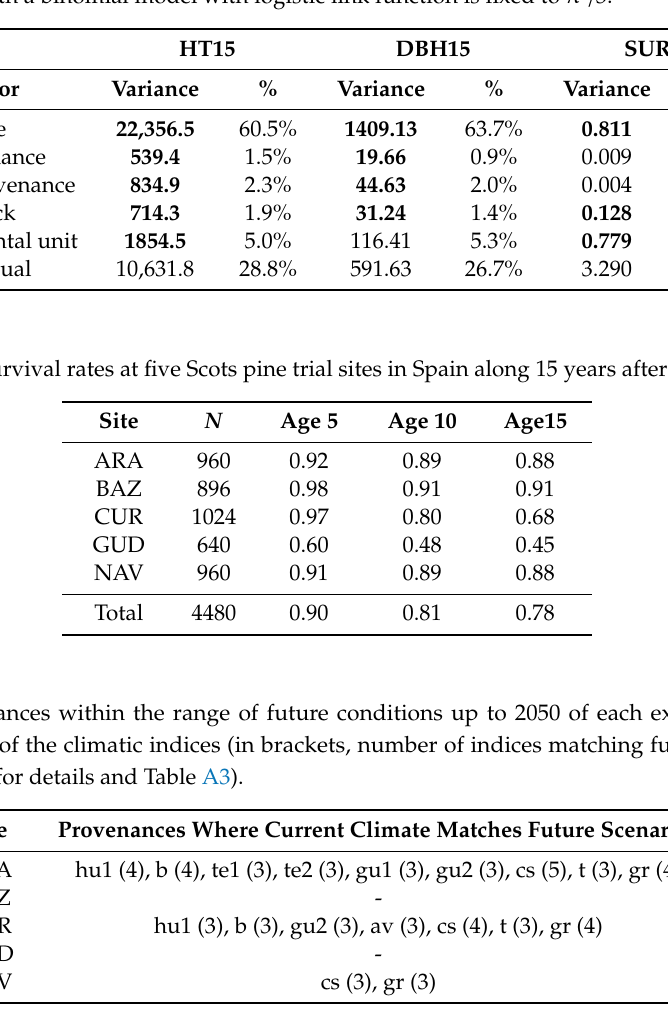
Table 3. Variance explained per variable and corresponding percentage relative to total variance, HT, height measured in cm at 15 years; DBH15, diameter at breast height measured in cm at 15 years, SUR15, survival at 15 years. Significant factors ( p < 0.05) are indicated in in bold. Residual variance for survival fitted with a binomial model with logistic link function is fixed to π 2 / 3.